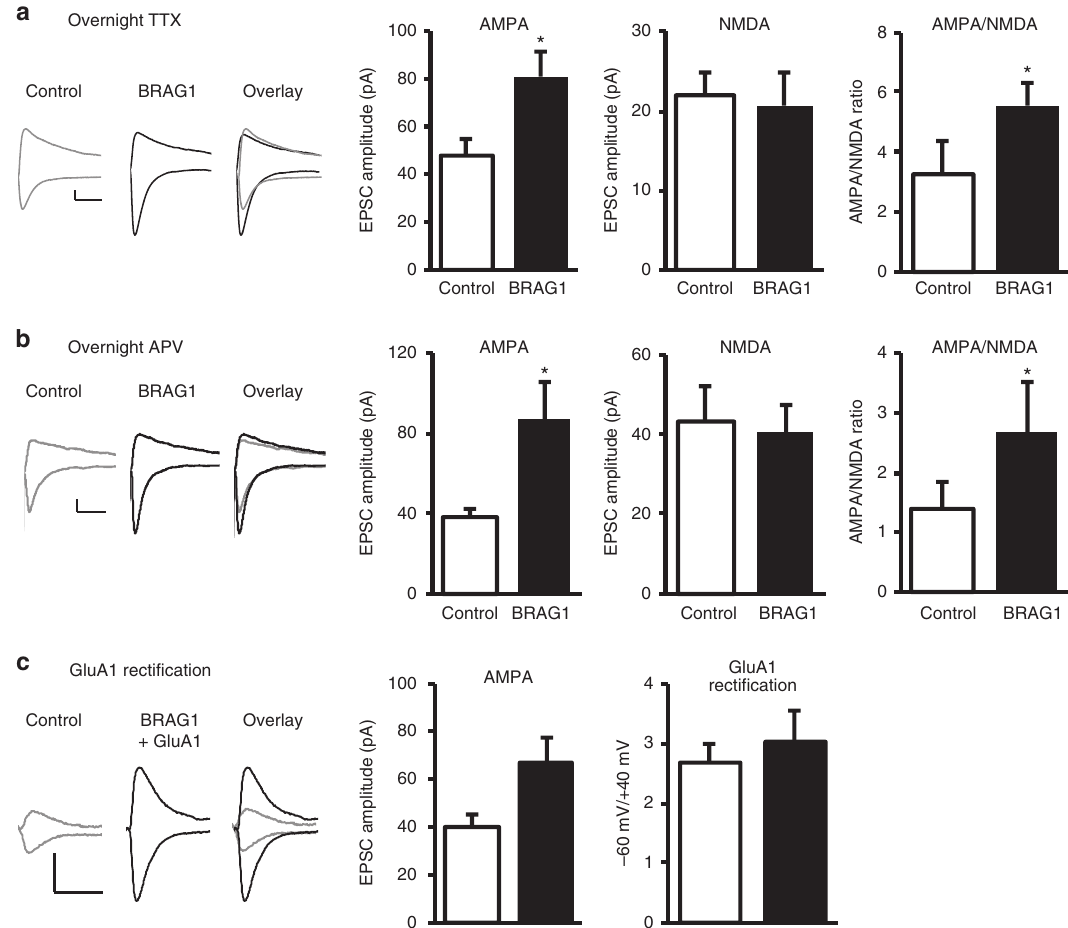
Figure 4 | BRAG1 enhances synaptic strength independently of synaptic activity or GluA1 insertion. ( a , b ) Insets: sample traces of AMPAR- and NMDAR-mediated synaptic responses recorded at (cid:2) 60 (left) and þ 40mV (right), respectively. Scale bars, 20pA, 20ms. Data represent averaged evoked EPSCs recorded for AMPA (left graphs), NMDA (middle graphs) and AMPA/NMDA ratios (right graphs) simultaneously from pairs of nearby untransfected and BRAG1-transfected CA1 neurons treated overnight with TTX ( a ; AMPA: n ¼ 8, P ¼ 0.013; NMDA: n ¼ 8, P ¼ 0.51; AMPA/NMDA: n ¼ 7, P ¼ 0.020) or APV ( b ; AMPA: n ¼ 9, P ¼ 0.023; NMDA: n ¼ 6, P ¼ 0.64; AMPA/NMDA: n ¼ 6, P ¼ 0.031). ( c ) Insets: sample traces of evoked AMPAR-mediated synaptic responses recorded at (cid:2) 60 and þ 40mV from control cells or cells co-transfected with BRAG1 and GluA1. Scale bars, 20pA, 20ms. Left graph shows AMPAR-mediated responses recorded at (cid:2) 60mV ( n ¼ 14, P ¼ 0.027). Right graph shows the rectification index, which was calculated as the ratio of the amplitude of AMPAR-mediated responses at (cid:2) 60mV to that at þ 40mV ( n ¼ 13, P ¼ 0.39). * Indicates significance ( P r